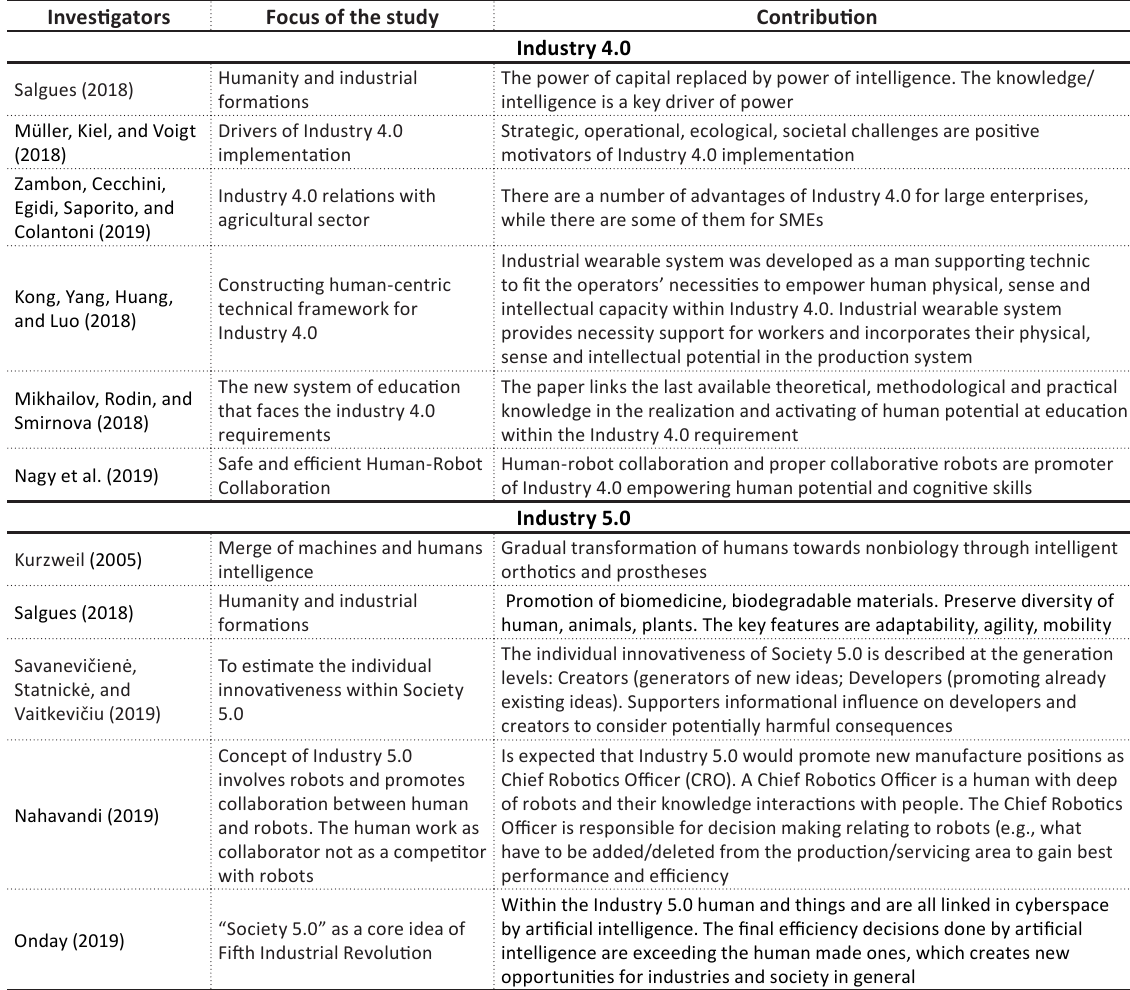
Table 2. The social systems transformations under the influence of industrial revolutions